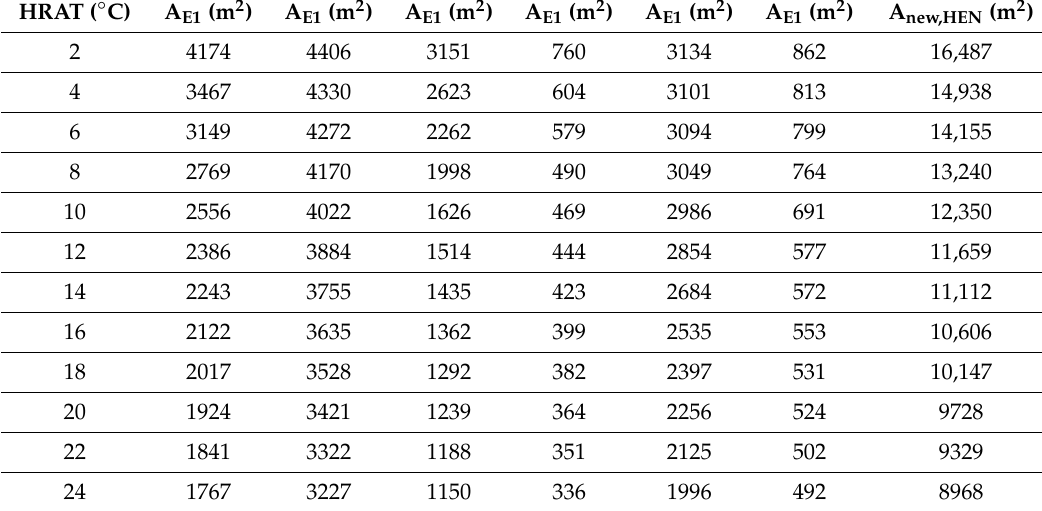
Table A13. Heat transfer area for HEN exchangers after heat-shifting, using option